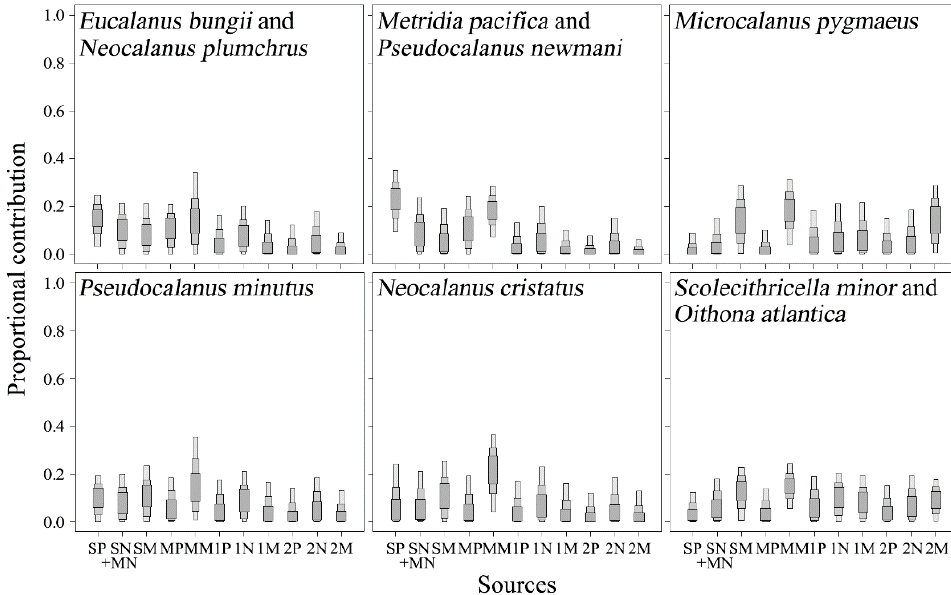
Figure 7. The stable isotope analysis in R mixing model results show the contributions of pico-, nano-, and micro-particulate organic matter (POM) at the surface (0 m, 10 m), SCM, 100 m, and 200 m depth layers to the diets of copepods in the north region of the subpolar front using δ 13 C and δ 15 N values. The shaded boxes (dark to light) show 50%, 75%, and 95% credibility intervals for mean estimates. SP, surface layer pico-POM; SN, surface layer nano-POM; SM, surface layer micro-POM; MP, SCM layer pico-POM; MN, SCM layer nano-POM; MM, SCM micro-POM; 1P, 100 m depth layer pico-POM; 1N, 100 m depth layer nano-POM; 1M, 100 m depth layer micro-POM; 2P, 200 m depth layer pico-POM; 2N, 200 m depth layer nano-POM; 2M, 200 m depth layer micro-POM. Based on the trophic relationship between micro-POM and small copepods and the diets of C. affinis in the south region and M. pygmaeus in the north region, the SIAR results showed that C. affinis fed mainly on small copepods rather than on micro-POM in the surface and SCM layers while M. pygmaeus fed on micro-POM in the 100 m and 200 m depth layers as well as on O. atlantica and S. minor (Figure 8).